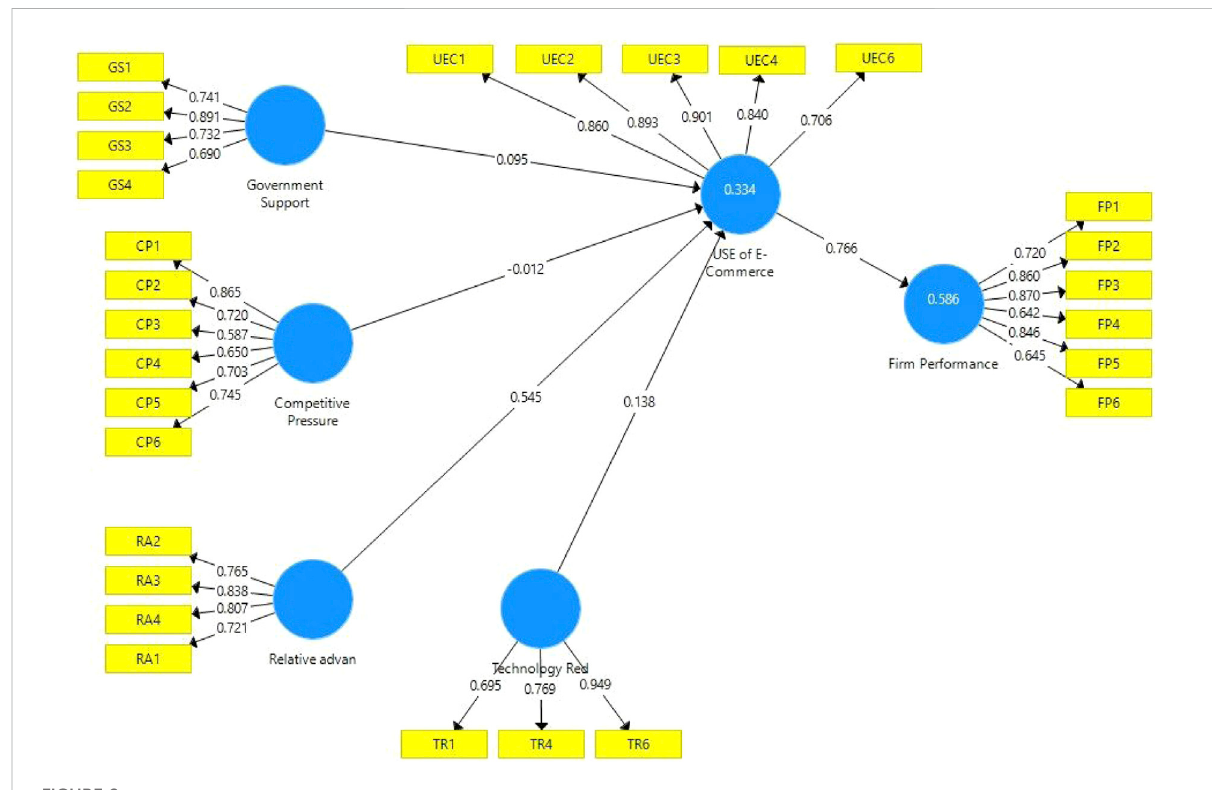
FIGURE 2 PLS algorithm of the measurement